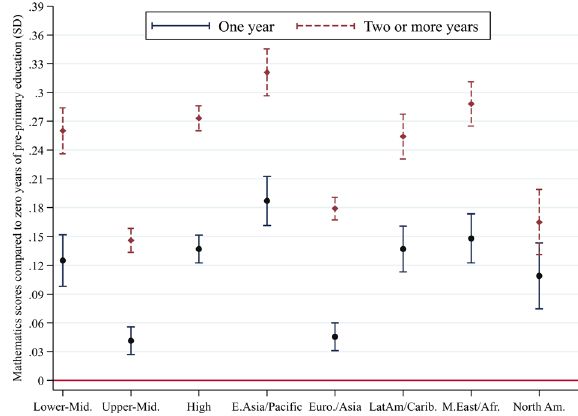
Fig. 1 Estimated average differences in mathematics test scores at age 15 between pre-primary programme participants and non- participants. Notes: Mathematics scores in standard deviations (SD) and con fi dence intervals for students with 1 year of pre-primary